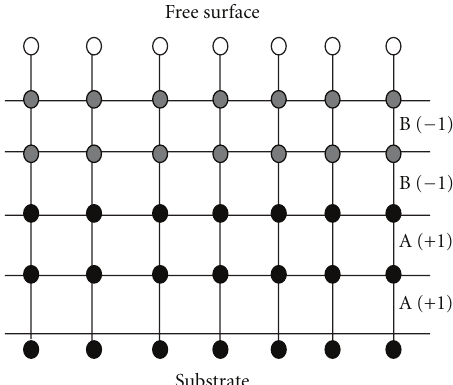
Figure 6: Shows the initial configuration of type A (spin +1) and type B (spin − 1) with respect to the substrate. In this paper, we have started with a random distribution of A-B in 30:70 ratio confined between two walls with strong preferential attraction to one the component B in our case and repulsive to another component in minority in this case A. Peroidic boundary conditions are applied in X